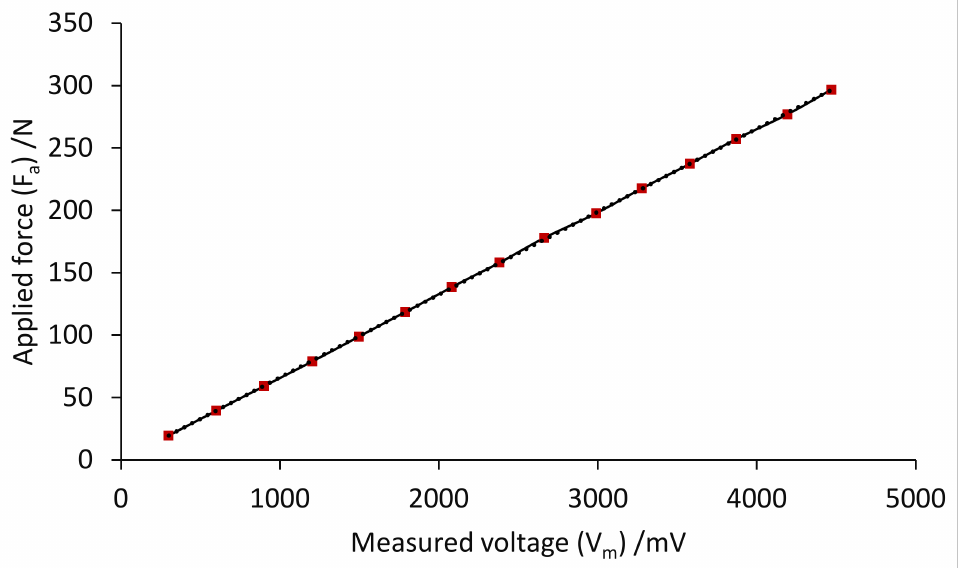
Figure 17. Calibration curve of applied force versus measured